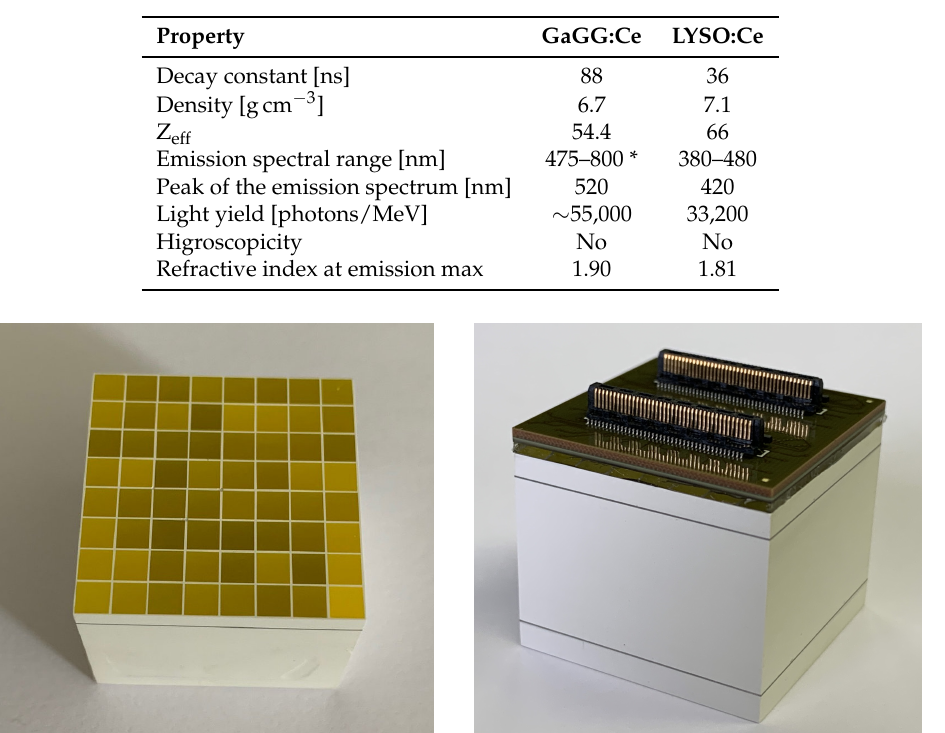
Table 1. The properties of GaGG(Ce) [26] and LYSO [2] according to the manufacturers. * We note that the upper limit of the emission spectral range of GaGG:Ce quoted in the literature is mostly between 650–750 nm [8,11,13].